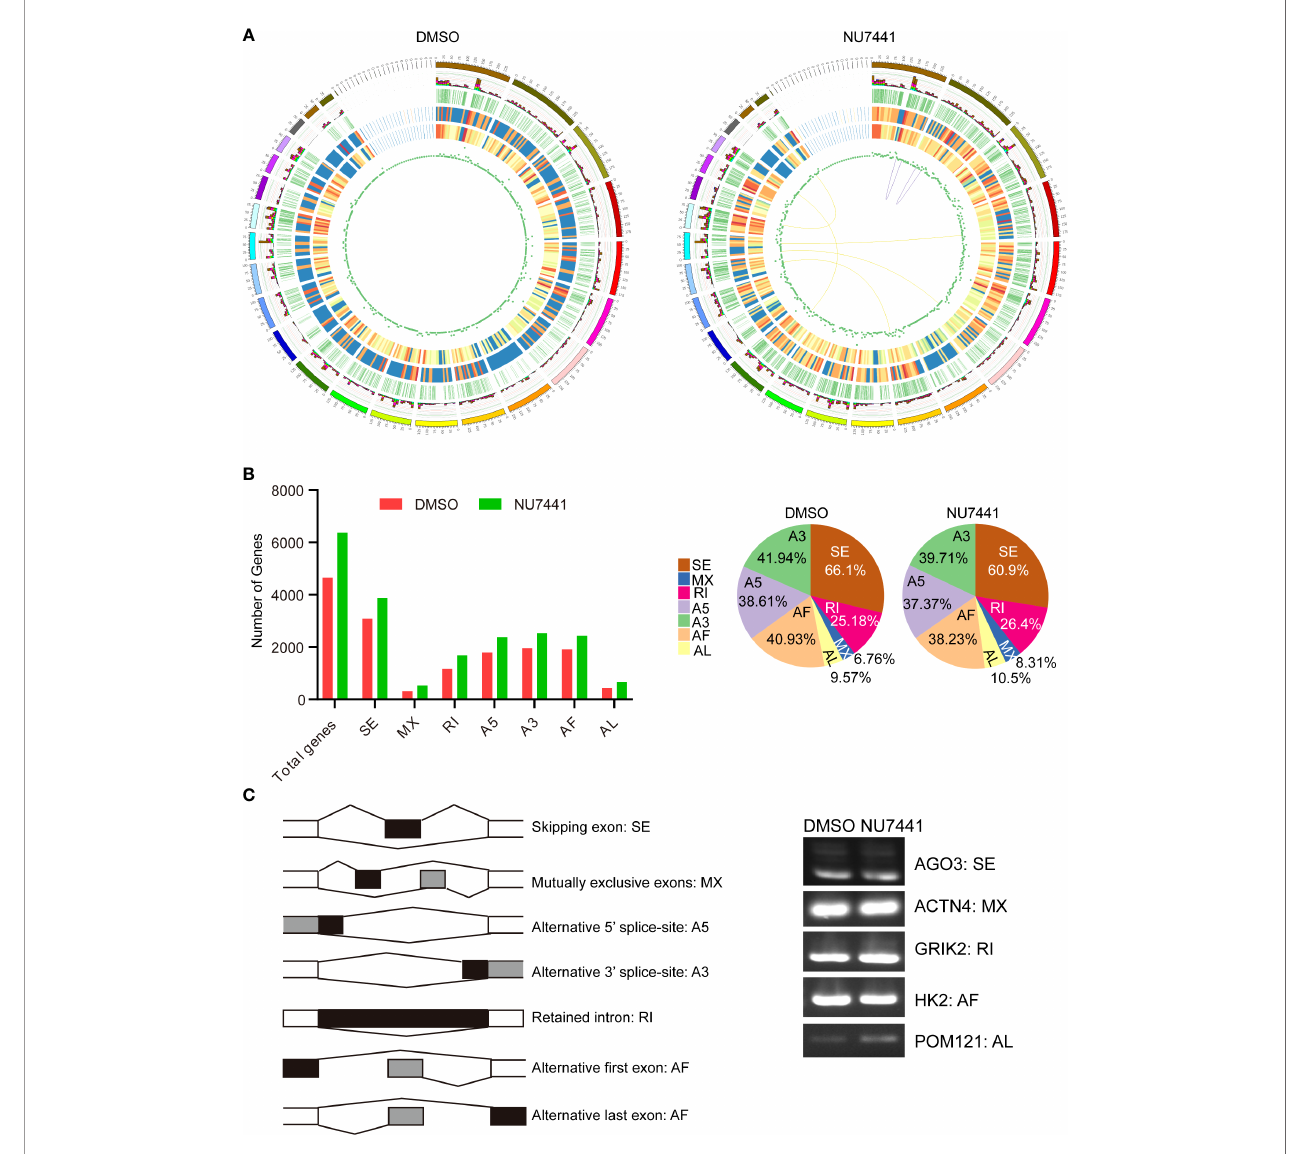
FIGURE 3 | Transcriptome structure analysis and alternative splicing pro fi ling in the long-read data. (A) The circus display of chromosome sequence; alternative splicing loci (light blue for intron retention, green for A3 alternative splicing, yellow for A5 alternative splicing, purple for exon skipping, red for mutual exclusive exons, brown for alternative fi rst exon, dark blue for alternative last exon); alternative polyadenylation loci; the distribution of new transcripts; novel gene distribution; lncRNA density distribution; gene fusions, purple line (same), yellow line (different) genes on chromosomes fused. (B) Alternative splicing patterns in the long-read data. The different splicing patterns were depicted in the left panel. The number of genes with different splicing events between control cells and NU7441-treated cells were summarized. The percentage of different splicing patterns was also shown in the pie chart. (C) Validation of the alternative splicing events in long-read data. Different splicing events for AGO3 , ACTN4 , GRIK2 , HK2 , and POM121 were validated by